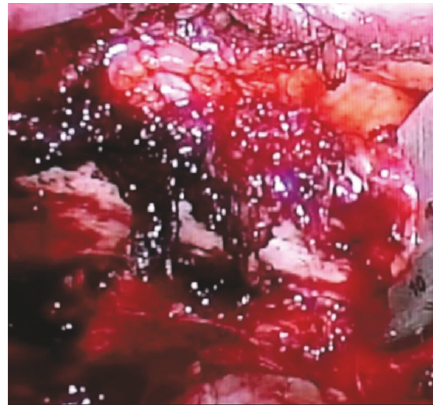
Figure 3: The endoscopic rib cutter is placed around the first